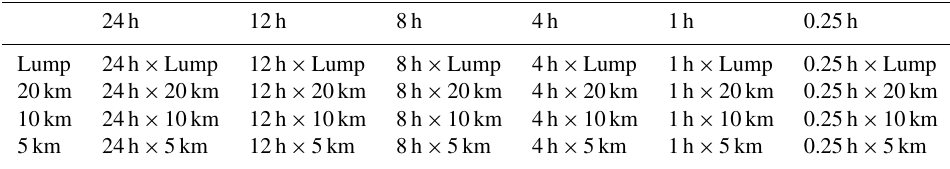
Table 2. Matrix of runs using different temporal ( x ) and spatial ( y ) resolutions.